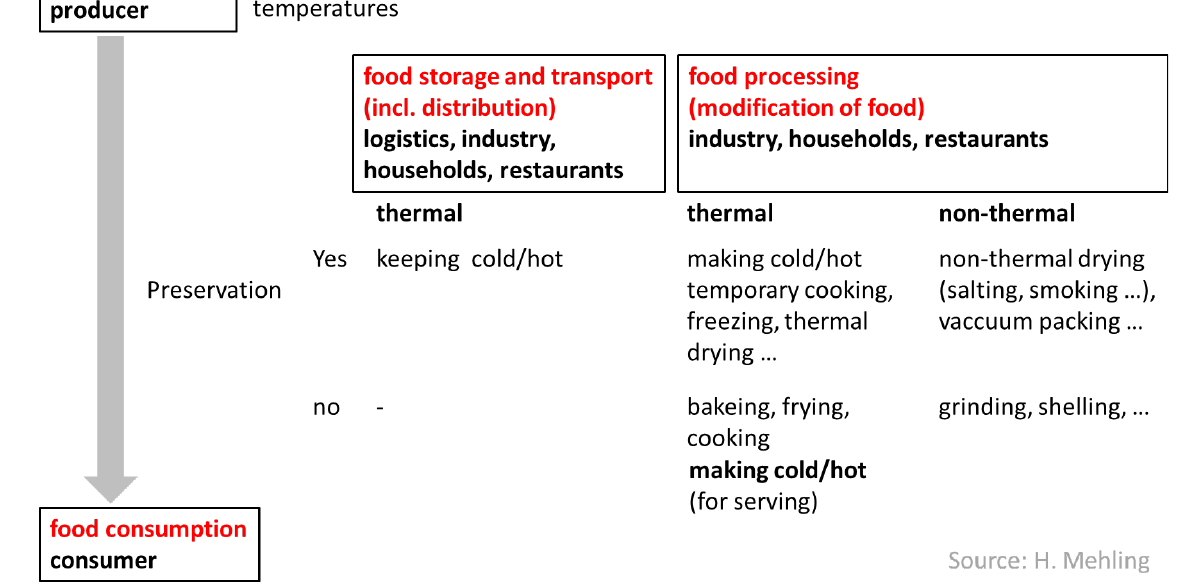
Figure 2. Overview on food applications, specifically thermal ones.